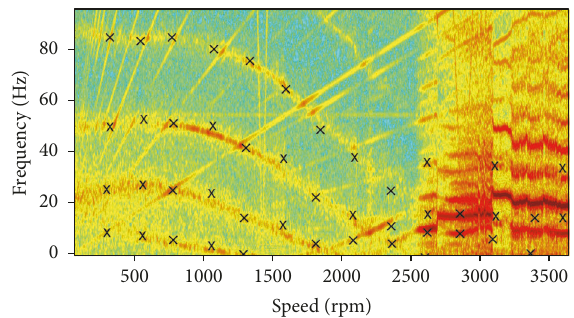
Figure 15: Variation of excited frequencies of the blade as a function of rotation speed. Color map experimental results; × represents the model